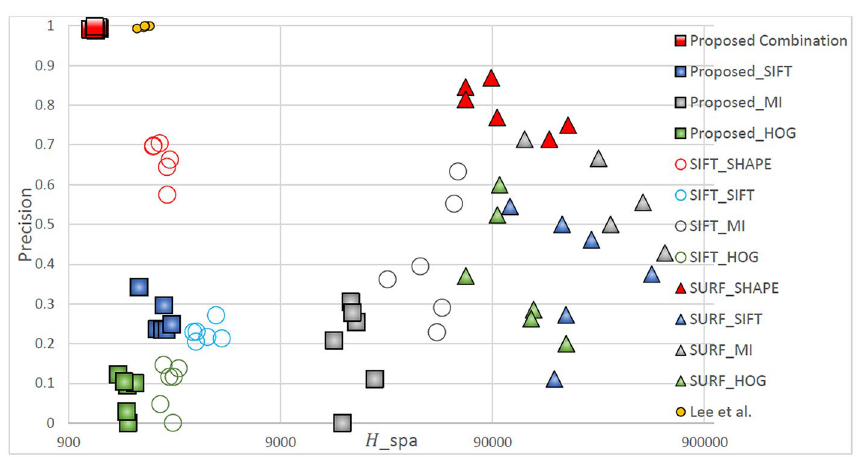
Figure 7. Quantitative comparison of matching in TYPE III through different matching